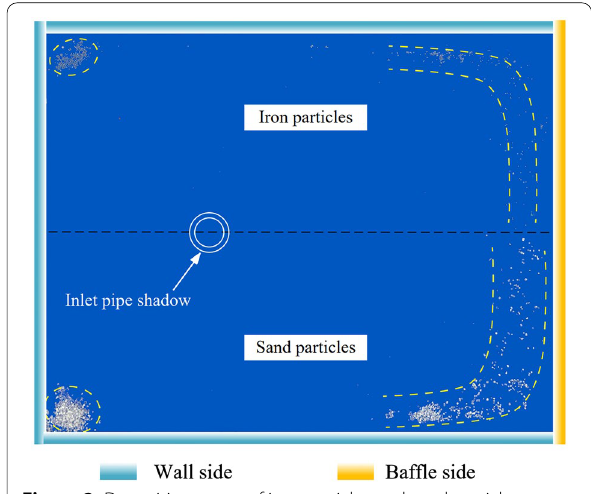
Figure 2 Deposition status of iron particles and sand